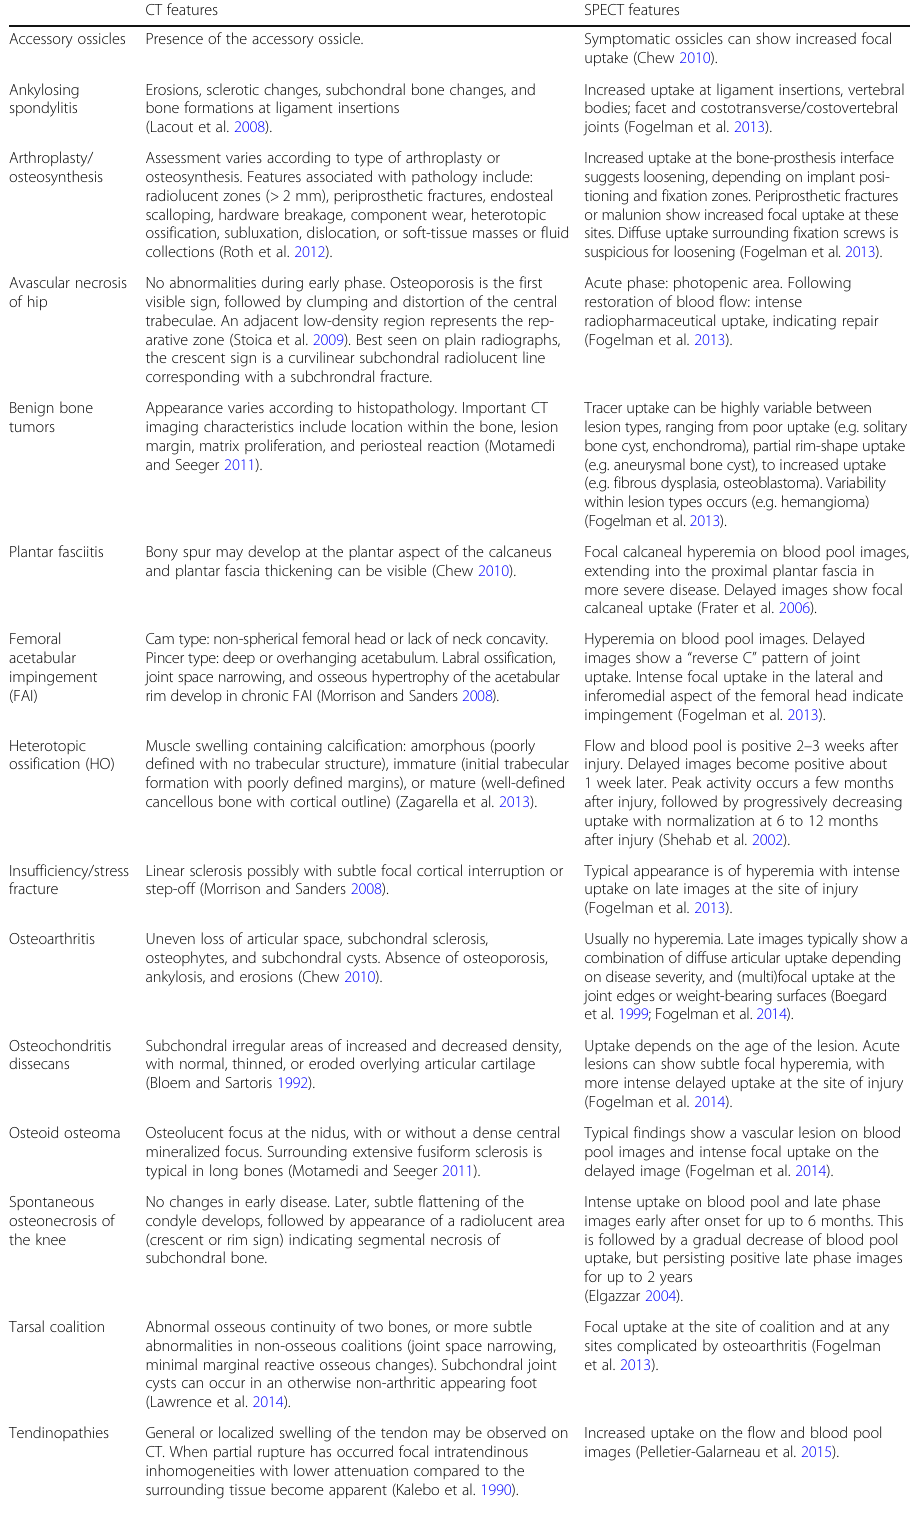
Table 1 Overview of imaging features in potential applications of bone SPECT/CT in the